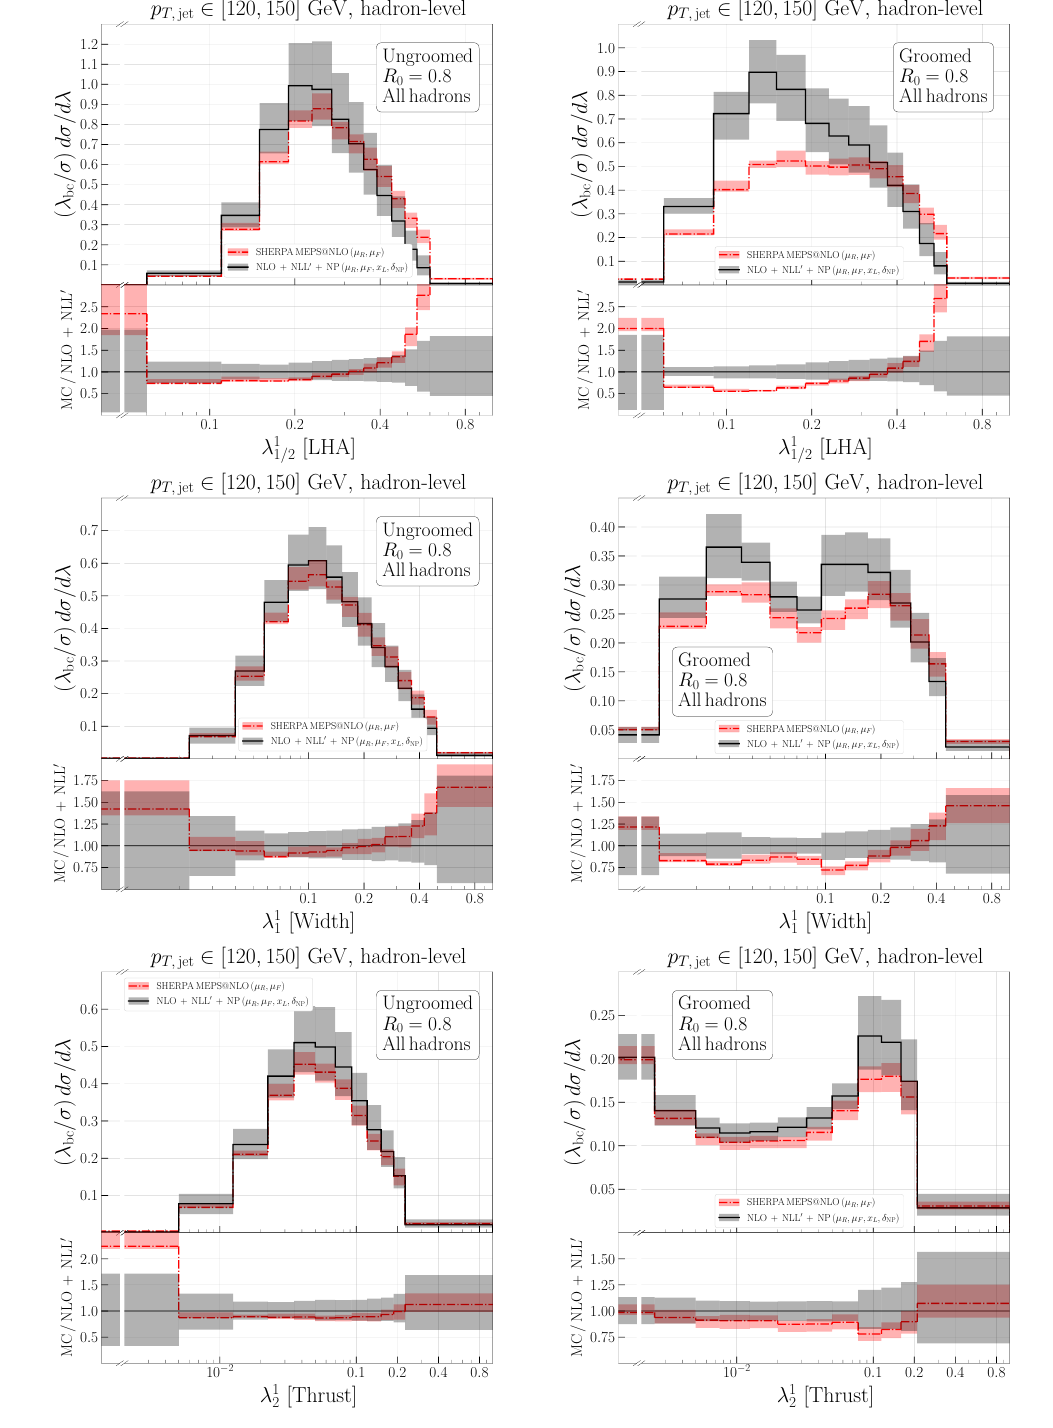
Figure 13 . Comparison of hadron-level predictions from S HERPA (MEPS@NLO), based on all final state hadrons, for ungroomed and groomed jet-angularities in Zj production, with p T, jet ∈ [120 , 150] GeV, with NLO + NLL 0 results corrected for non-perturbative effects. Here λ bc stands for the bin